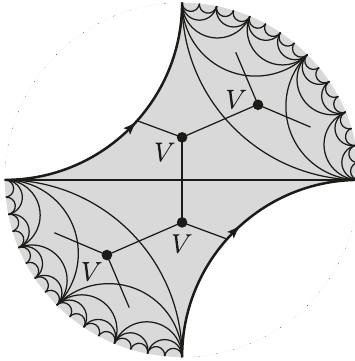
Figure 22 . A tessellation (cid:28) BTZ for the BTZ spacetime. The two geodesics marked with arrows are identi(cid:12)ed.